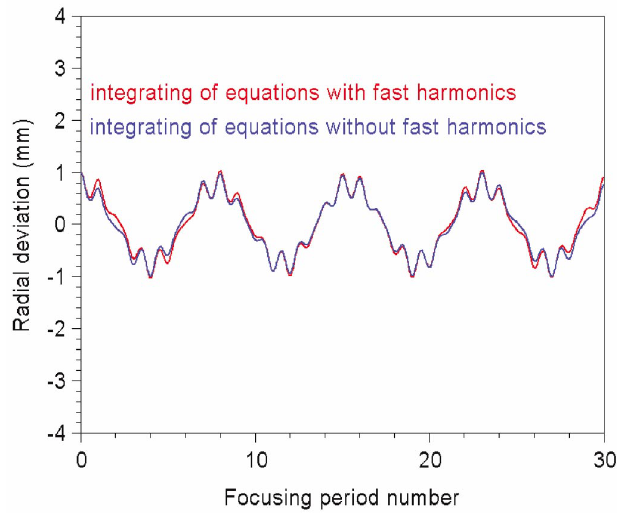
FIG. 12. (Color) Comparison of integrating results with (44) and without (45) fast harmonics in transverse